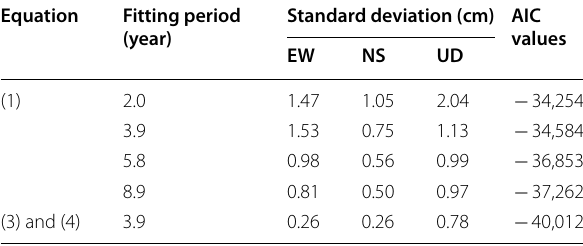
Table 2 Standard deviation and AIC values of the residuals for each fitting period